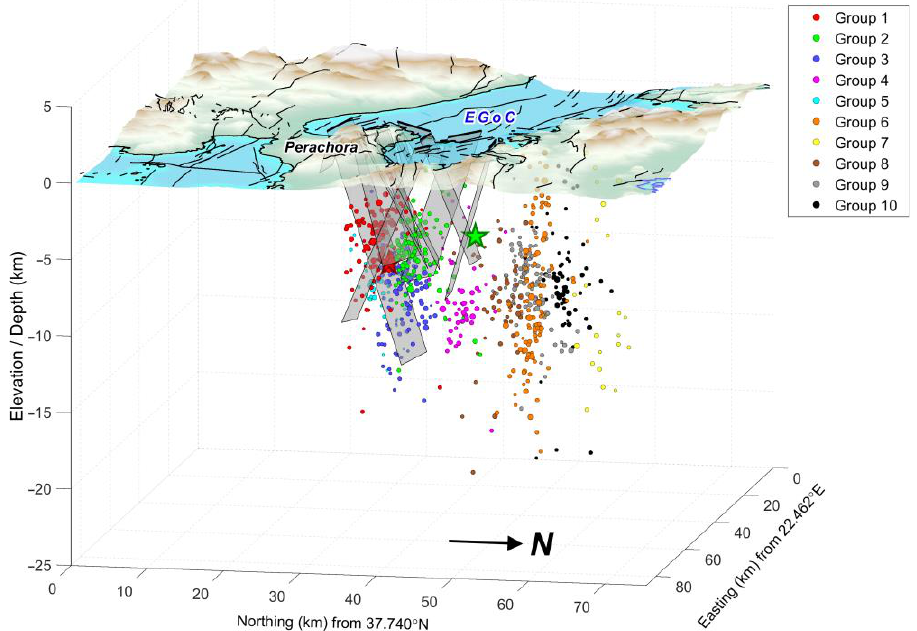
Figure A11. Snapshot of the 3D interactive MATLAB figure available in the Supplementary Materials (File M1). The view is from a low angle toward WSW, with 2 × vertical exaggeration. Some of the extruded fault planes at depth are visible, along with the hypocenters of the 10 spatial groups of CAT1 (Figure 3a). Fault lines are from the NOAFaults v4.0 database [48,49].